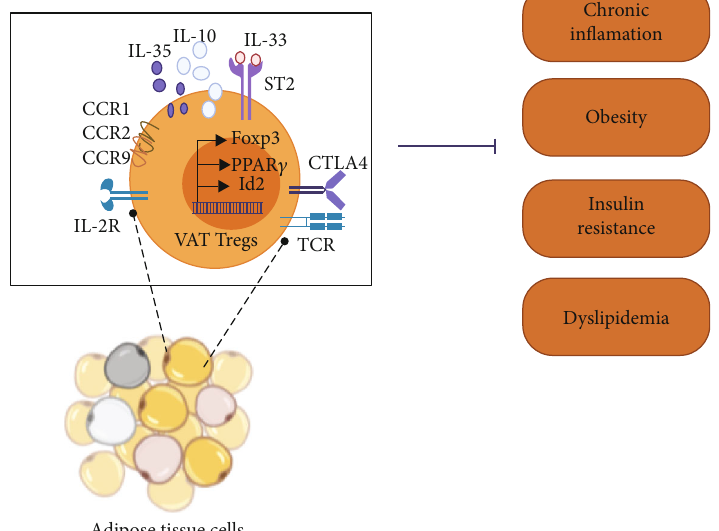
Figure 1: The surface markers, secreted cytokines, and basic functions of VAT Treg cell. The VAT Tregs express phenotypic conventional Treg markers (FoxP3, CD25, and CTLA-4). They produce functional cytokines, IL-10 and IL-35. PPAR- γ and Id2 are the key regulators of these cells. Besides, a large set of chemokines and chemokine receptors is highly expressed by VAT Tregs, including CCR1, CCR2, and CCR9. The VAT Tregs are a bridge between immunity and metabolism, which play an important role in multiple autoimmune diseases.